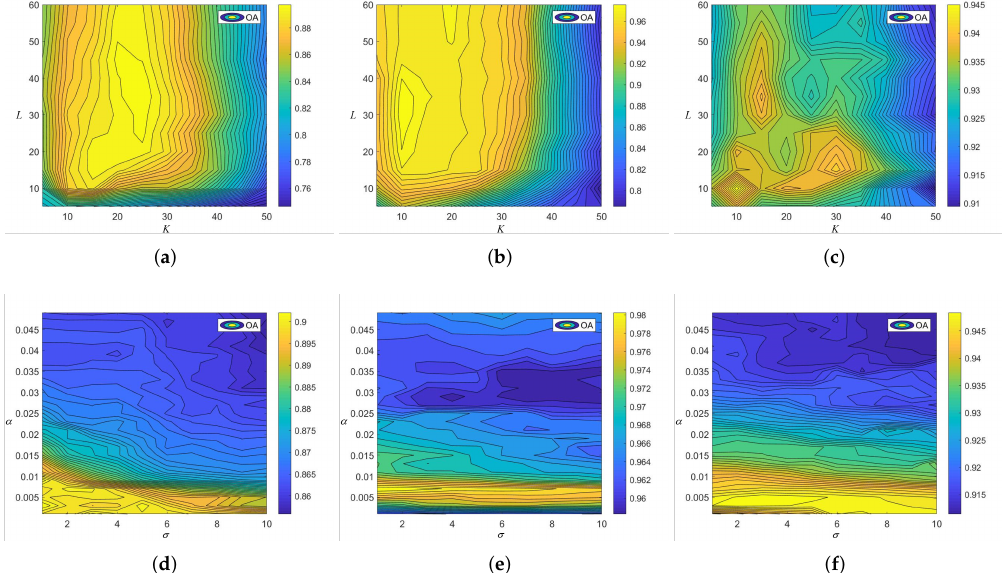
Figure 11. The influence of different parameters in the proposed method. The first row is the influence of the number of dimension reduction L and the number of fused feature K . The second row is the influence of the smoothing parameter α and the window size σ . ( a ) Indian Pines dataset; ( b ) Salinas dataset; ( c ) Honghu dataset; ( d ) Indian Pines dataset; ( e ) Salinas dataset; ( f ) Honghu dataset.